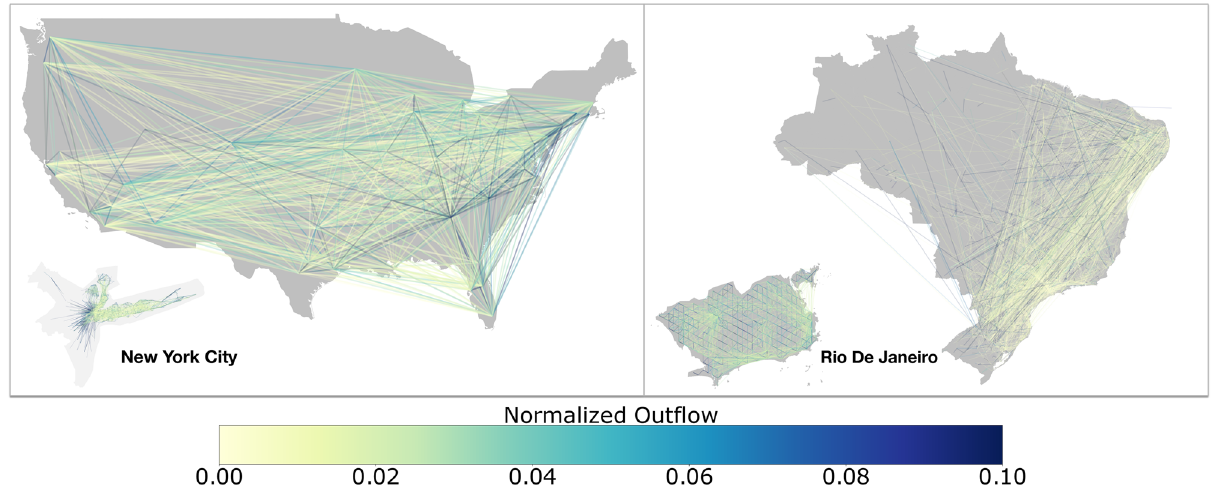
Figure 1. Visualization of mobility data. Flows at the country level for the US (left-panel), with New York City shown in the inset. Flows at the country level for Brazil (right-panel), with Rio shown in the inset. (Map generated using the Shapely (https:// pypi. org/ proje ct/ Shape ly/) and GeoPandas (https:// geopa ndas. org/) packages in